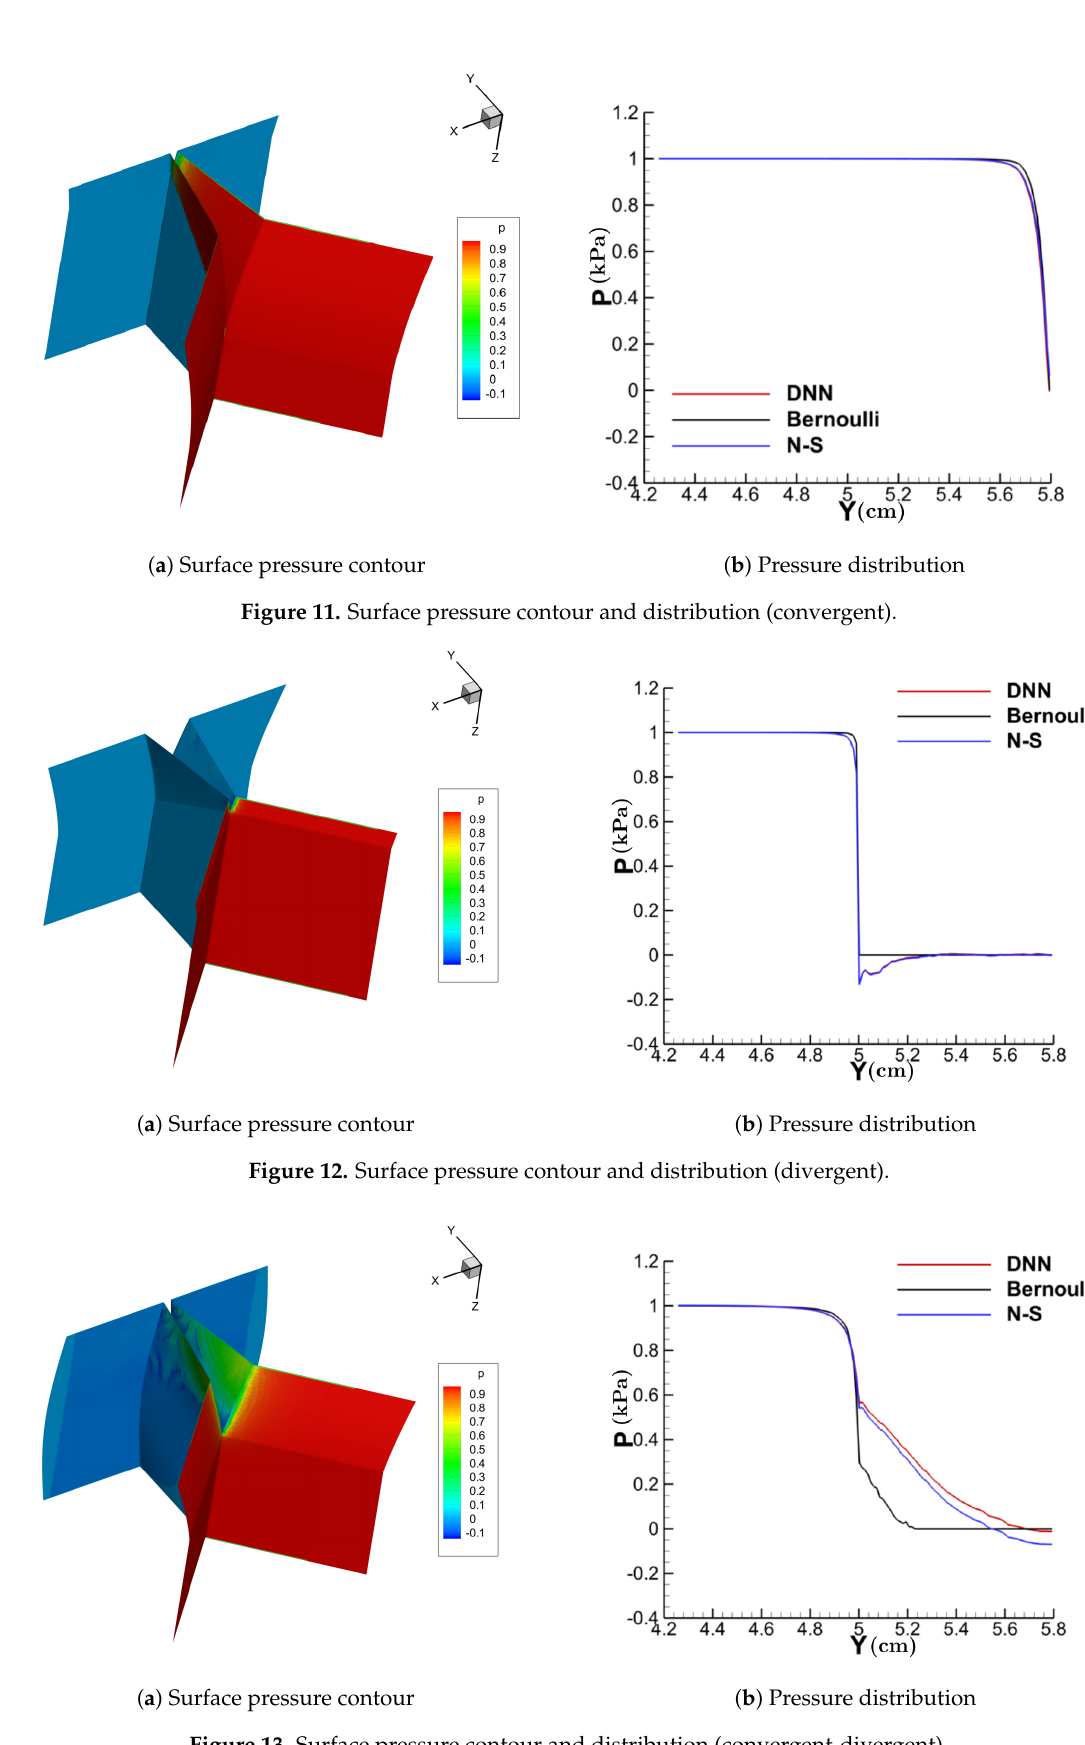
Figure 13. Surface pressure contour and distribution